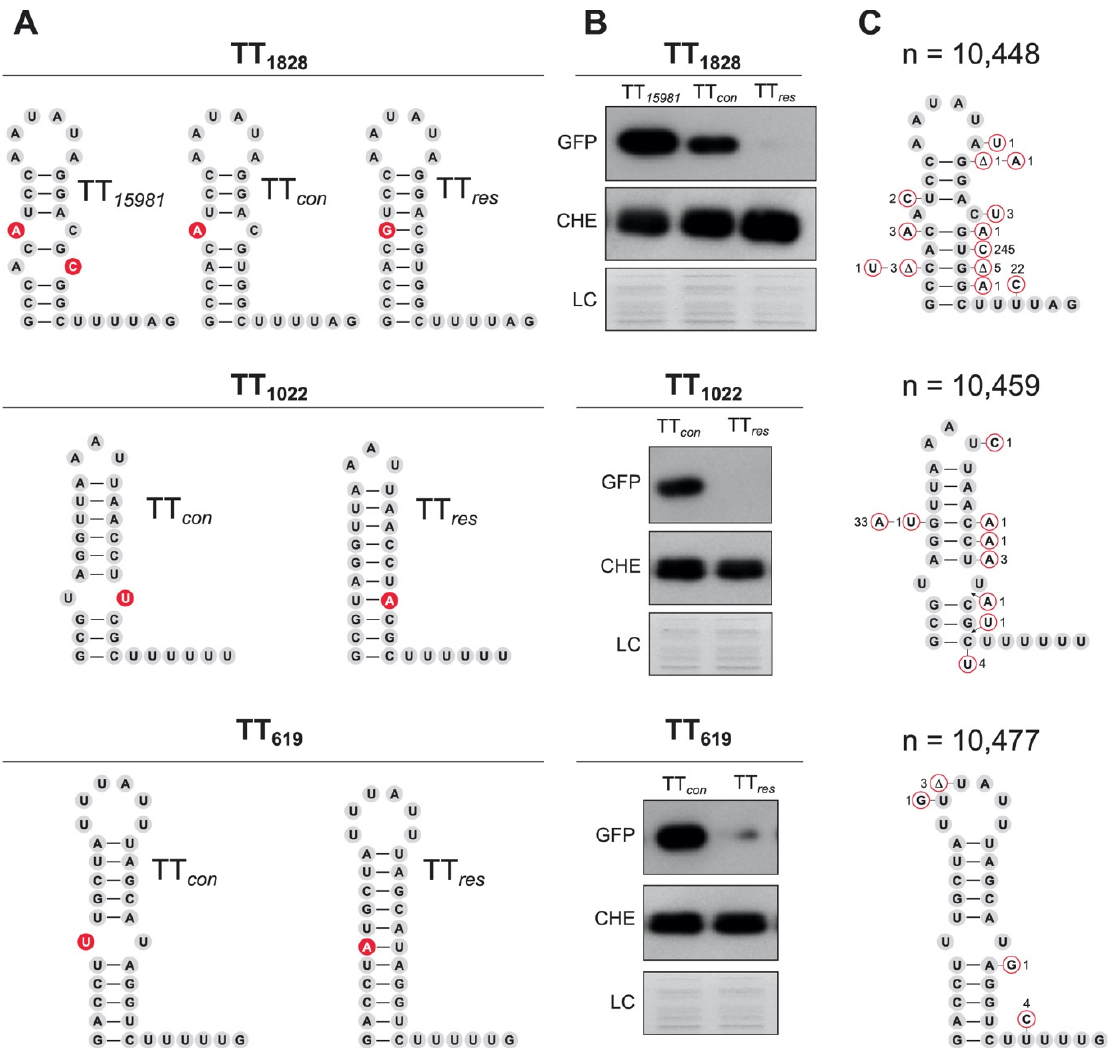
Figure 8. Evolutionarily selected mispairing nucleotides in TTs are relevant for read-through events. ( A ) Structures of predicted TTs (1828, 1022 and 619) including mispairings and restored TT variants (res) that compensated the mispairings. Nucleotide changes are colored in red. ( B ) The TT read-through levels from each variation were monitored by Western blot analyses using the dual fluorescent reporter plasmid shown in Supplementary Figure S6. The GFP expression levels indicate the amount of transcriptional read-through while mCherry monitors the transcript level expressed from the P sbrB promoter. Proteins transferred to nitrocellulose membranes were developed as indicated in Figure 6. Coomassie-stained gel portions are included as loading controls. ( C ) Identification of natural nucleotide variations in the corresponding TTs. The sequences of the selected TTs were compared by BLASTN against all S. aureus genomes available in the NCBI database. n represents the number of genomes compared for each TT. The nucleotide variations and the number of genomes carrying such variations are indicated in the corresponding TT position.